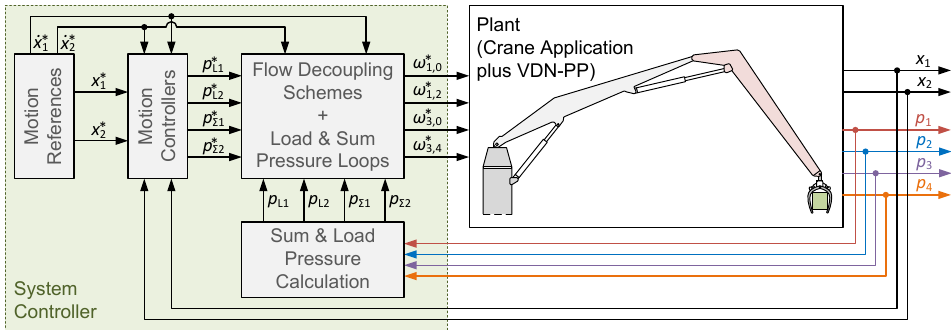
Figure 15. System control structure for VDN-PP actuated crane. The control structures for the VDN-L and VDN-LS appear in a similar way. Note that • ∗ reference for a variable •